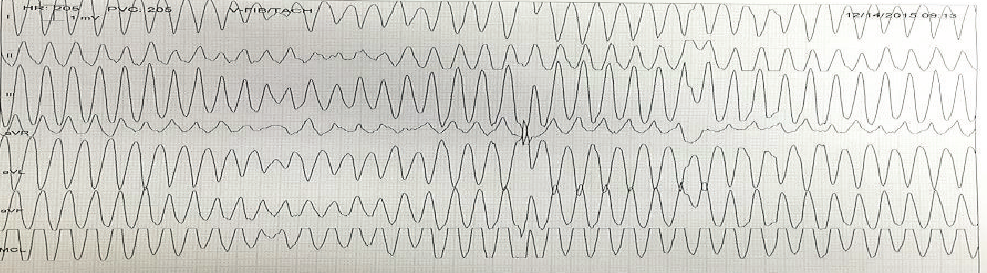
Figure 3: After 22 hours of admission, telemetry strip showing TdP.